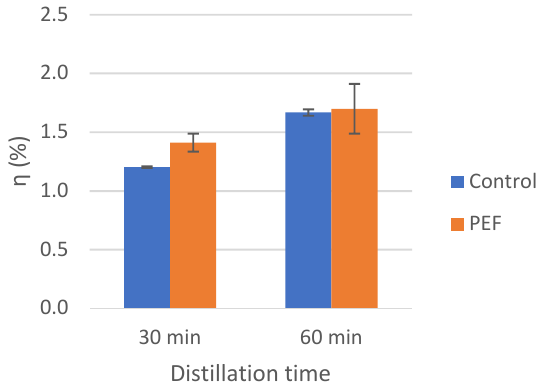
Figure 3. Results of yield of eucalyptus EO extracted with (PEF) and without PEF application (Control), and different HD times. Vertical lines indicate the dispersion, calculated from the amplitude of the results.